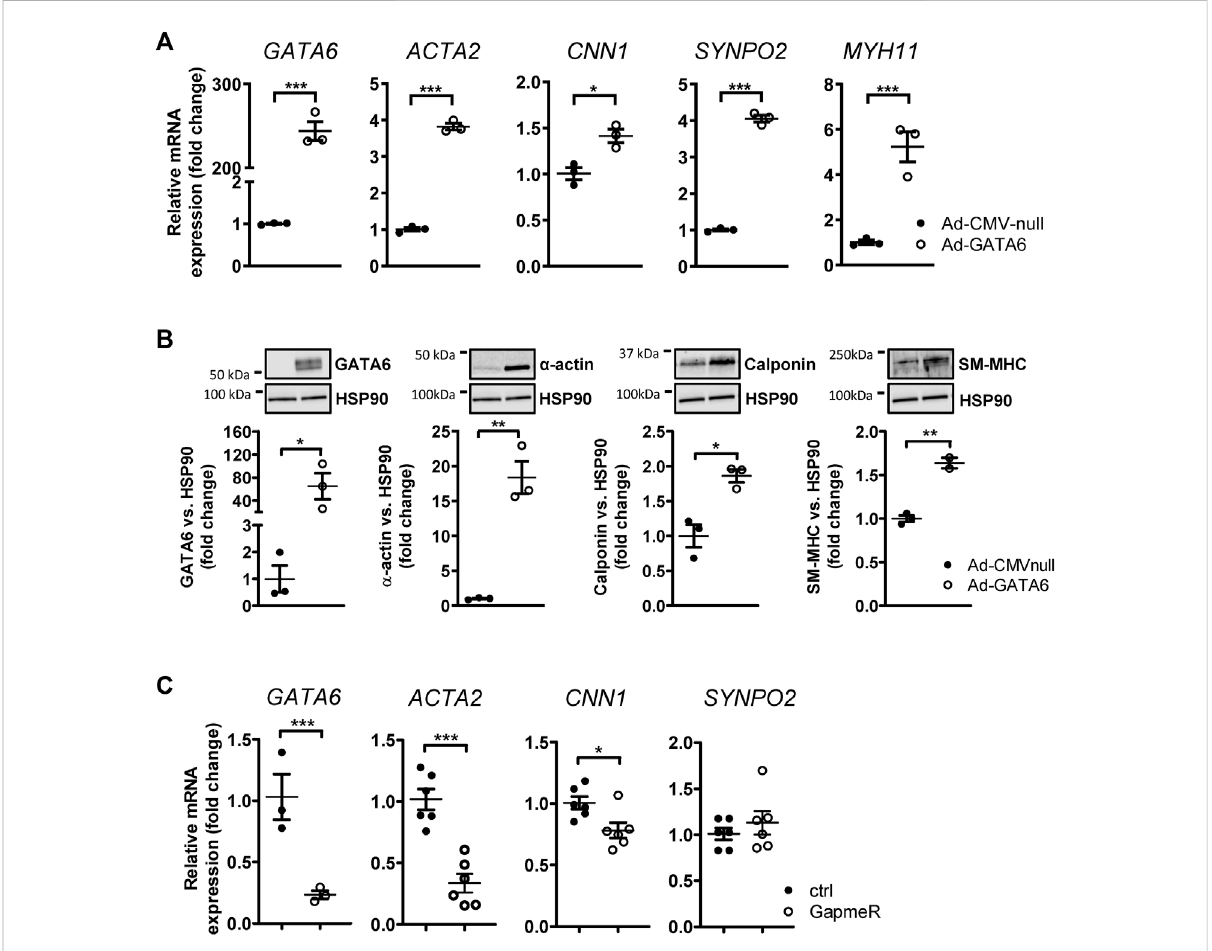
FIGURE 1 GATA6 induces vascular smooth muscle cell differentiation. Human coronary artery smooth muscle cells were transduced with Ad-CMV- GATA6/Ad-CMV-null (A,B) . Expression of GATA6 and some smooth muscle markers are presented in (A) at mRNA level and (B) at protein level. (C) Relative mRNA expression of targets after transfection with GapmeRs against GATA6. Data are presented as mean ± SEM ( n = 3 – 6). * p < 0.05, ** p < 0.01, *** p < 0.001. α -actin ( ACTA2 ), smooth muscle myosin heavy chain (SM-MHC, MYH11 ), calponin ( CNN1 ), and synaptopodin-2 ( SYNPO2